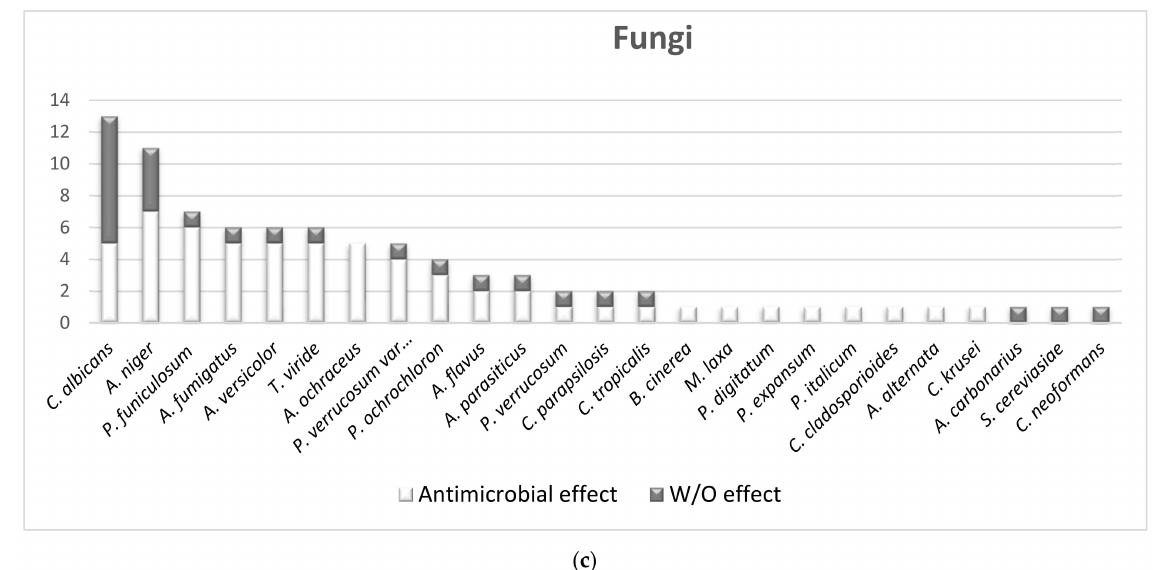
Figure 4. Number of studies (ordinate axis) of antimicrobial properties of MWEPs on Gram-negative (27 species), Gram- positive (18 species) bacteria and fungi (25 species). In different colors, we grouped the studies displaying an antibacterial effect (in white) and those in which no antibacterial (W/O, short for without) effect (in grey) could be included according to our thresholds. ( a ). Gram-positive bacteria; ( b ). Gram-negative bacteria; ( c ).